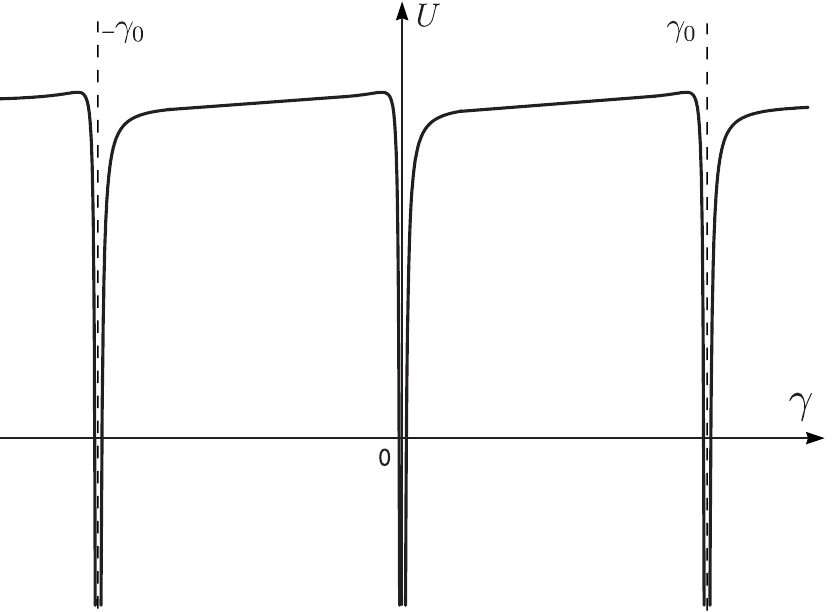
Figure 2. The potential energy for the birth of a new universe, as a result of gravitational